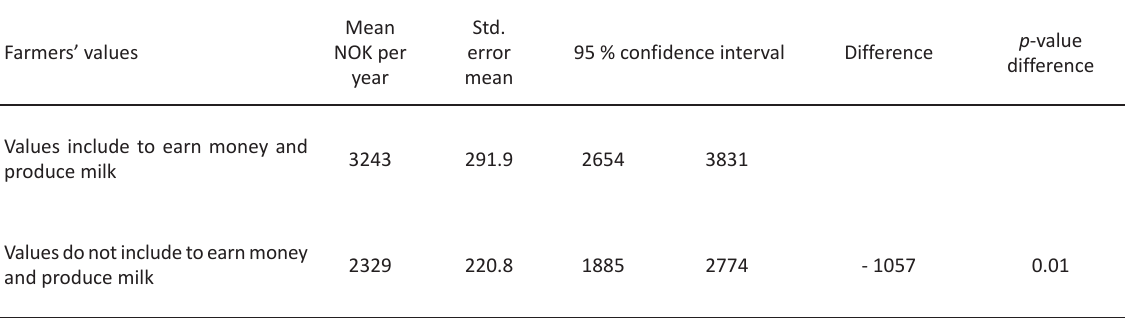
Table 7. Student’s t-test of the relationship between how much money farmers spend on consultancy services and whether their values include earning money and producing milk or not, n=89.